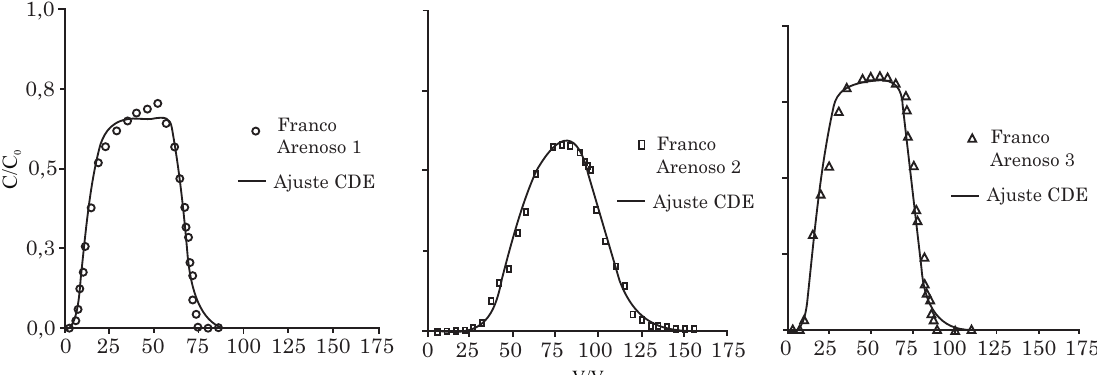
Figura 2. Curvas médias de eluição do naftaleno ajustadas pelo modelo CDE, em colunas de solos Franco-arenoso 1, Franco-arenoso 2 e Franco-argilossiltoso, na vazão de 0,45 mL min -1 e na concentração de 20 mg L -1